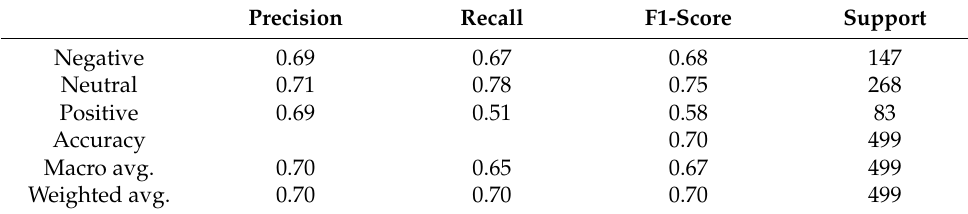
Table 7. Sentiment classifier using